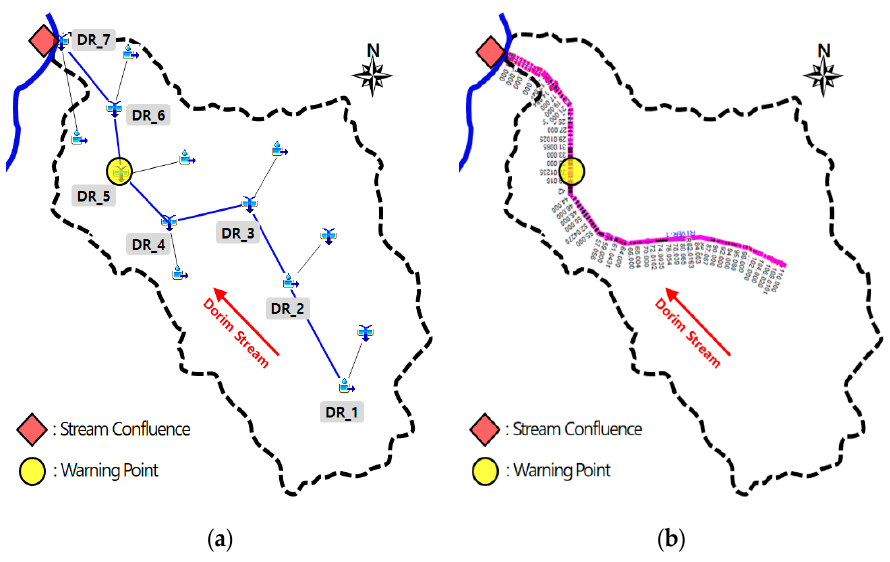
Figure 5. Rainfall threshold analysis method for flood warning. ( a ) Construction of HEC-HMS model, ( b ) Construction of HEC-RAS model.